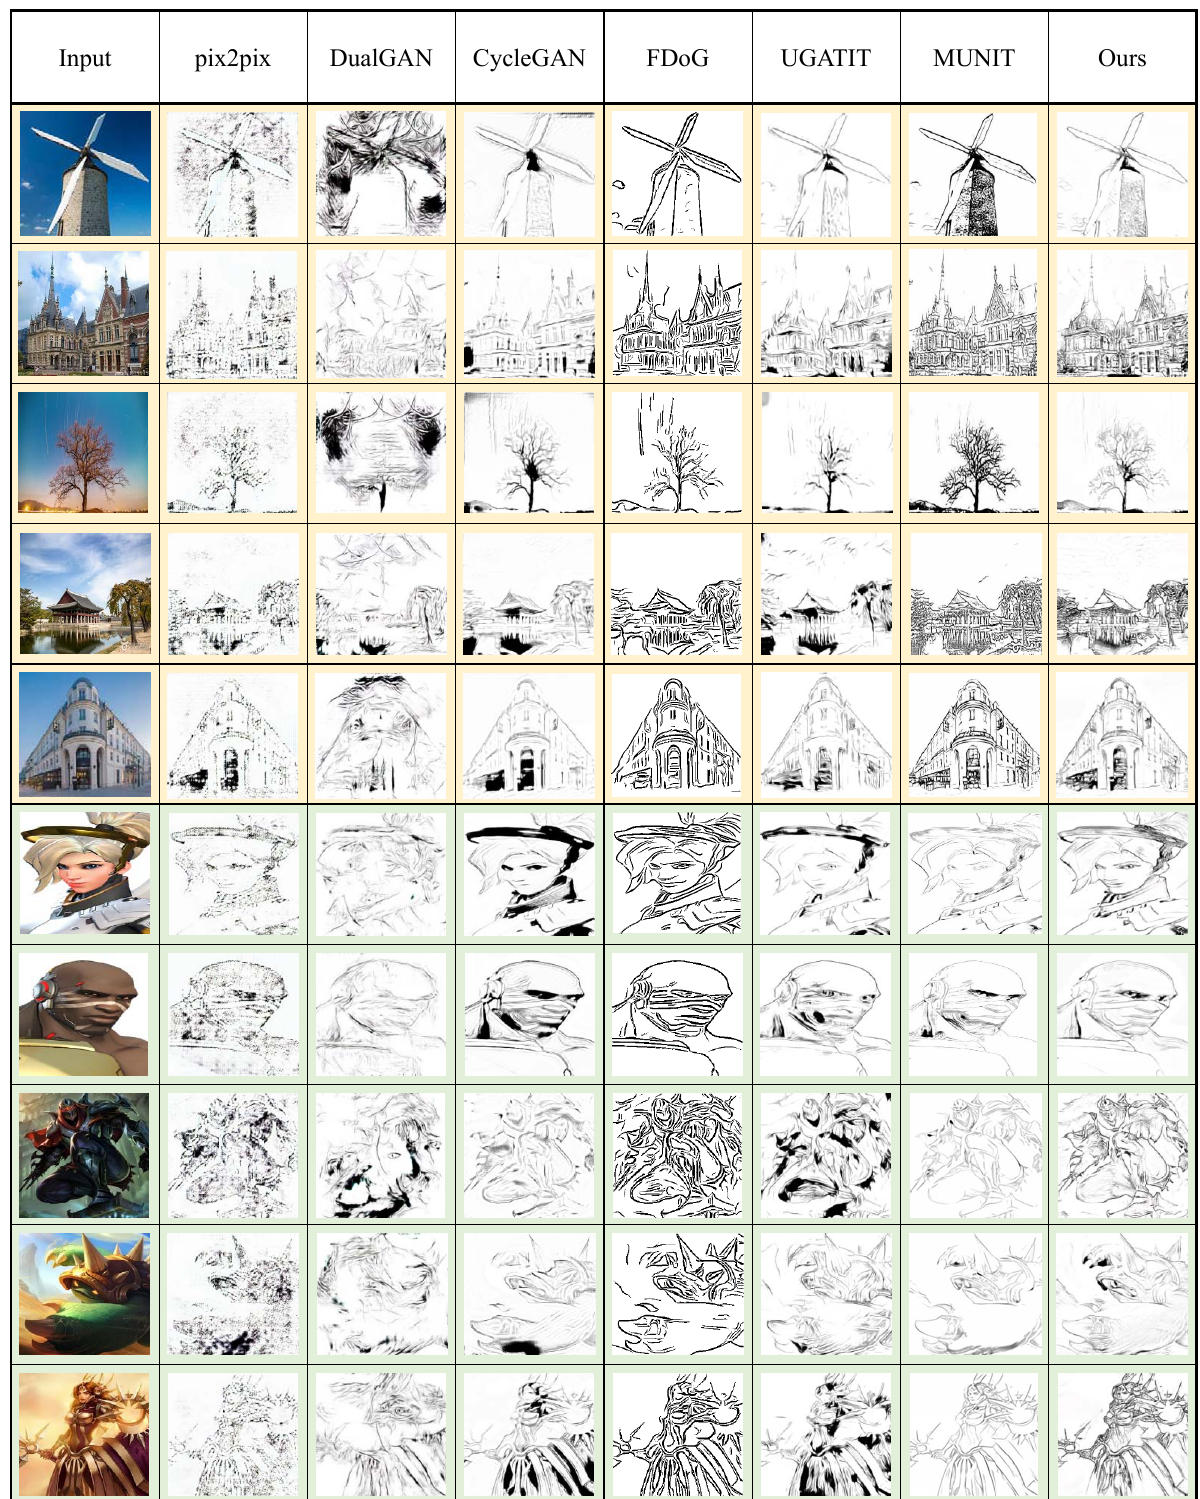
Figure 12. Our illustrative sketch images compared with existing works: The landscapes are contained in yellow cells and synthesized in